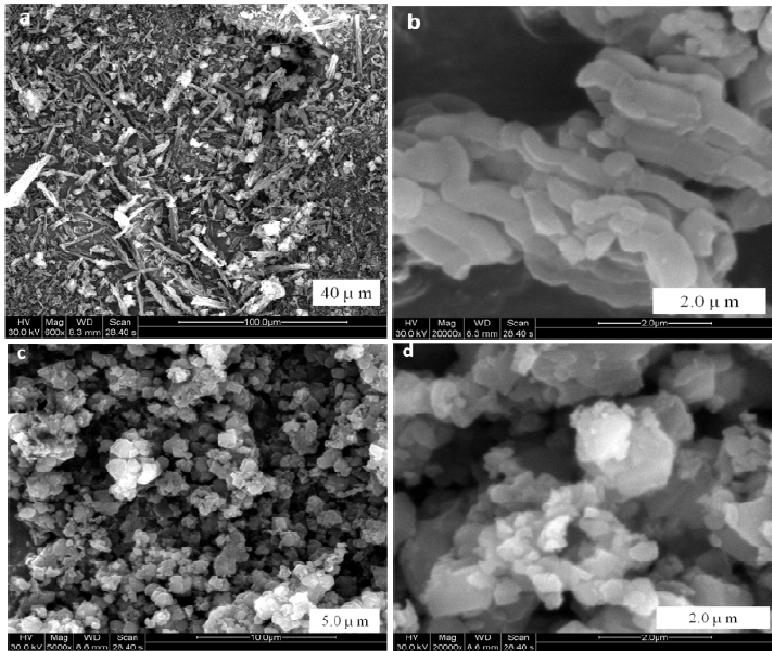
Figure 2. Scanning electron micrographs (SEM) images of MZ1 ( a , b ) and MZ2 ( c , d )